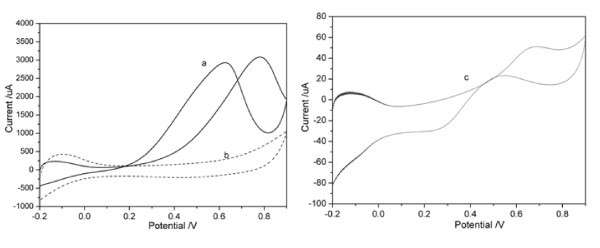
Cyclic voltammograms of (a) Pt-PEDOT/GC and (c) Pt disk electrode in 1 M CH3OH + 0.5 M H2SO4, and (b) Pt-PEDOT/GC in 0.5 M H2SO4 . Scan rate: 100 mV/s.